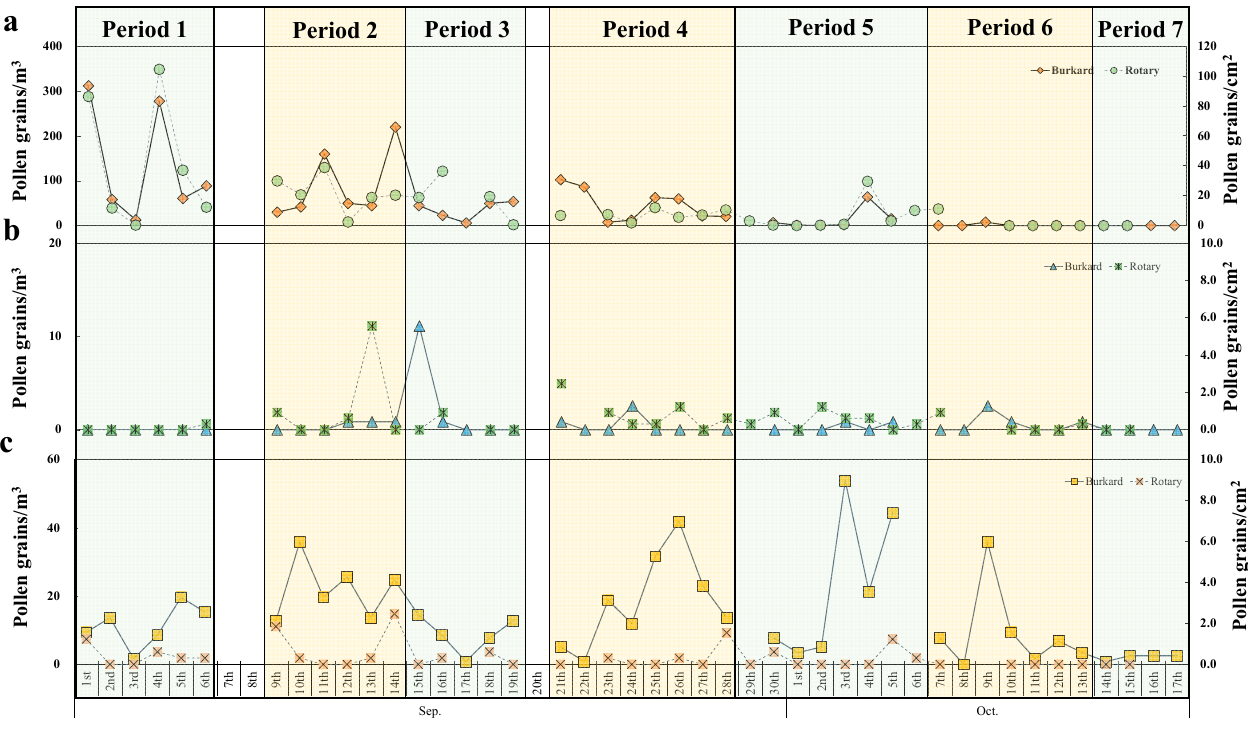
Figure 3. The temporal characterization of airborne herbaceous pollen, as measured using Burkard and rotary samplers: ( a ) ragweed; ( b ) mugwort; ( c ) Humulus japonicus .